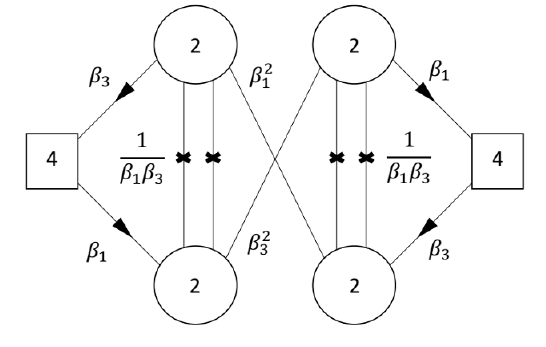
Figure 30 . The theory resulting from gluing the tubes II and III